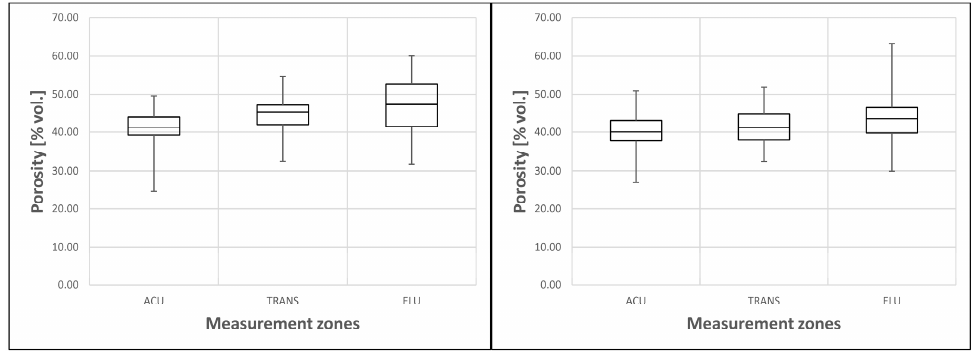
Figure 5. Bulk density at the depths of 10 ( left ) and 30 cm ( right ) in the soil profile.